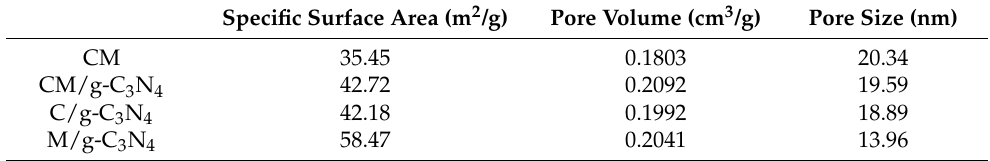
Figure 5. N 2 adsorption–desorption isotherms of different catalysts (g-C 3 N 4 ; M/g-C 3 N 4 ; C/g-C 3 N 4 ; CM/g-C 3 N 4 ; CM). Table 1. Specific surface area and pore characteristics of different catalysts (g-C 3 N 4 ; M/g-C 3 N 4 ; C/g-C 3 N 4 ; CM/g-C 3 N 4 ; CM).